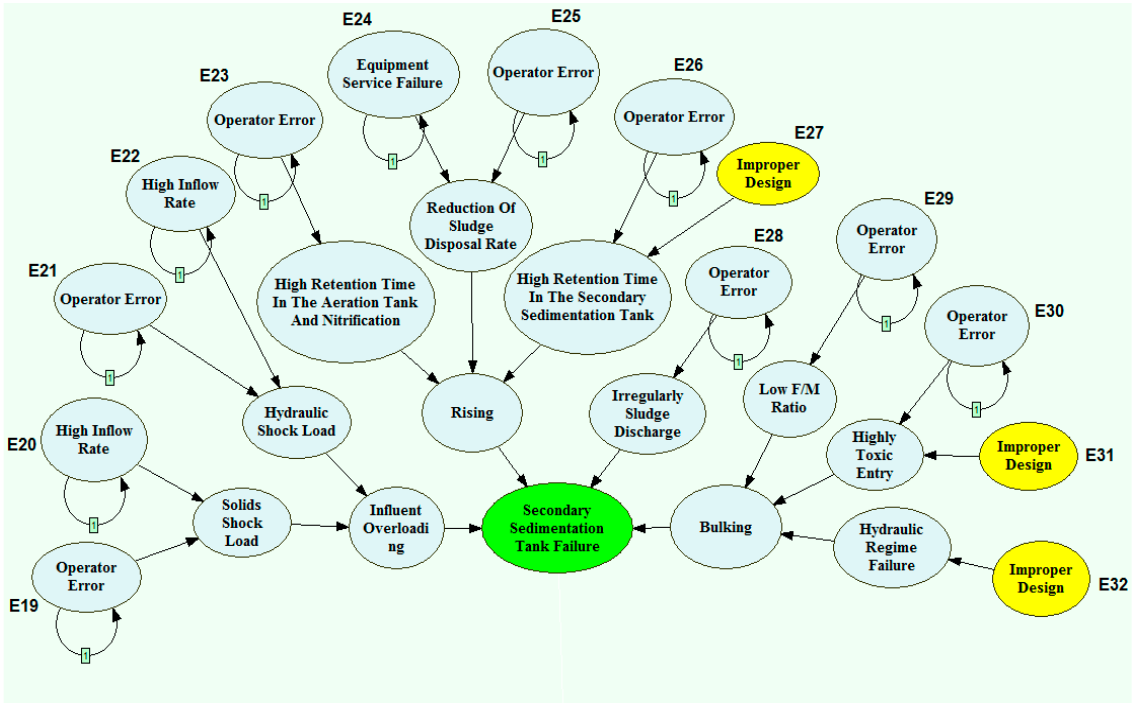
Figure 7. The DBN model of the MIC WWTP (part 2—Performance of the secondary sedimentation tank).